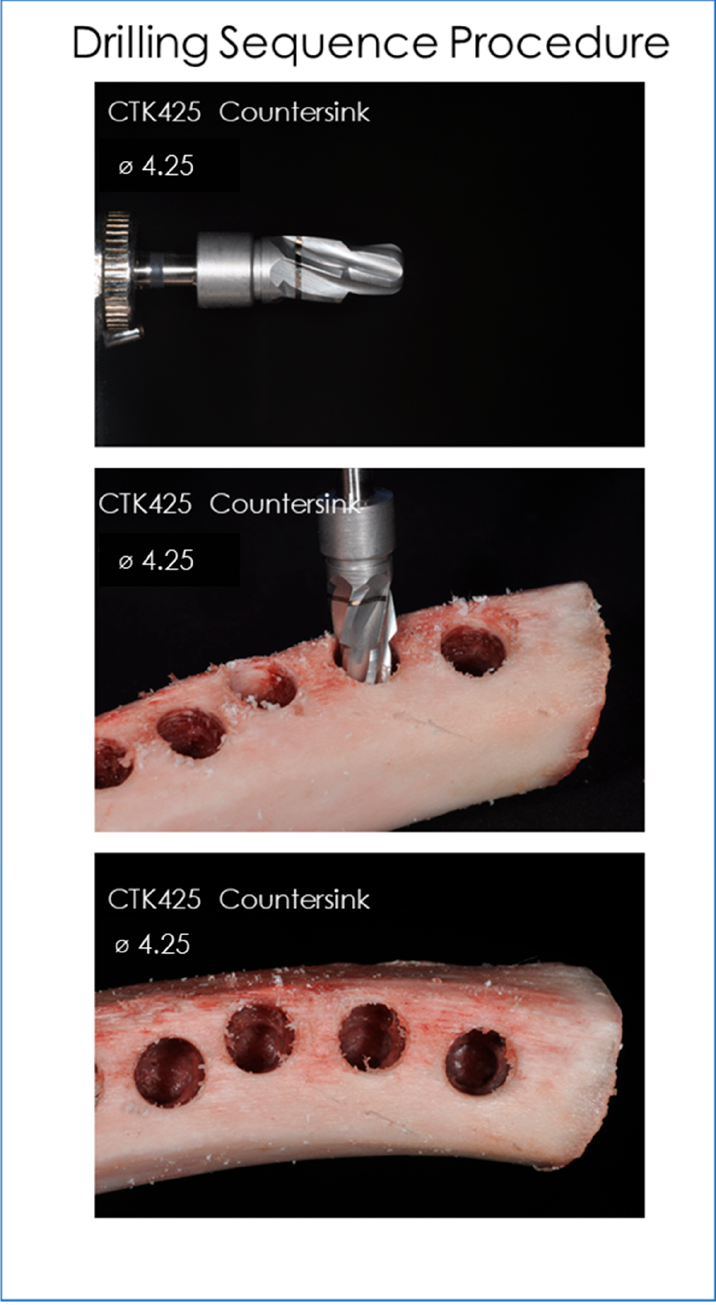
Figure 4. Details of the countersink drilling sequence (continued).